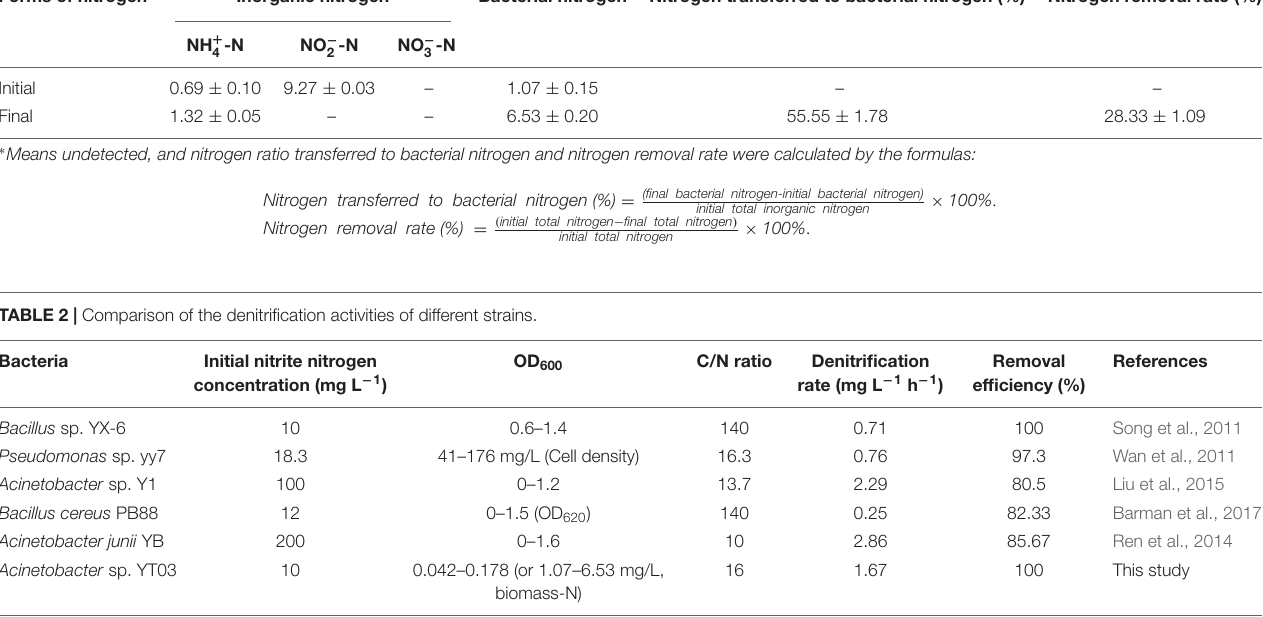
TABLE 1 | Nitrogen balance during aerobic denitrification by YT03 with nitrite sole nitrogen source (mg L − 1 ) ∗ . Forms of nitrogen